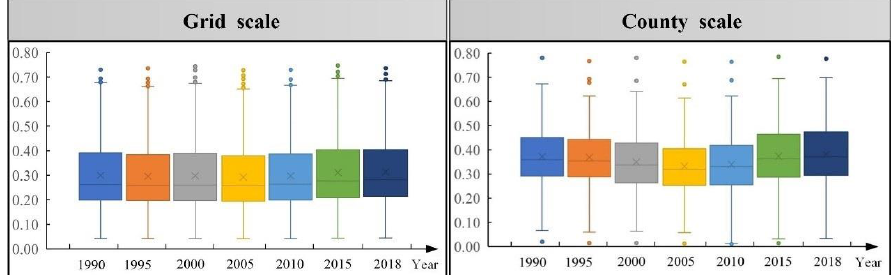
Figure 4. Box plot of ecosystem health change at grid and county scale.